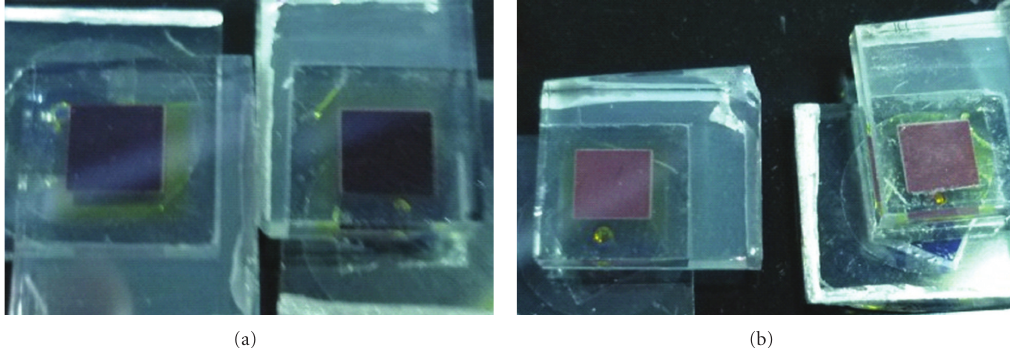
Figure 5: Photographs of DSCs using TiO 2 -BM (a) and TiO 2 -MG (b).